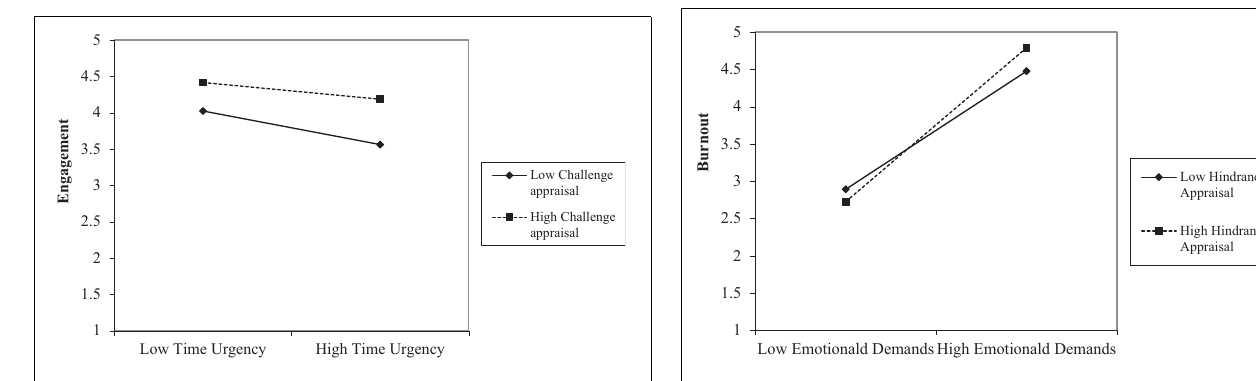
FIGURE 2 | The interaction between emotional demands and hindrance appraisal on burnout in Study